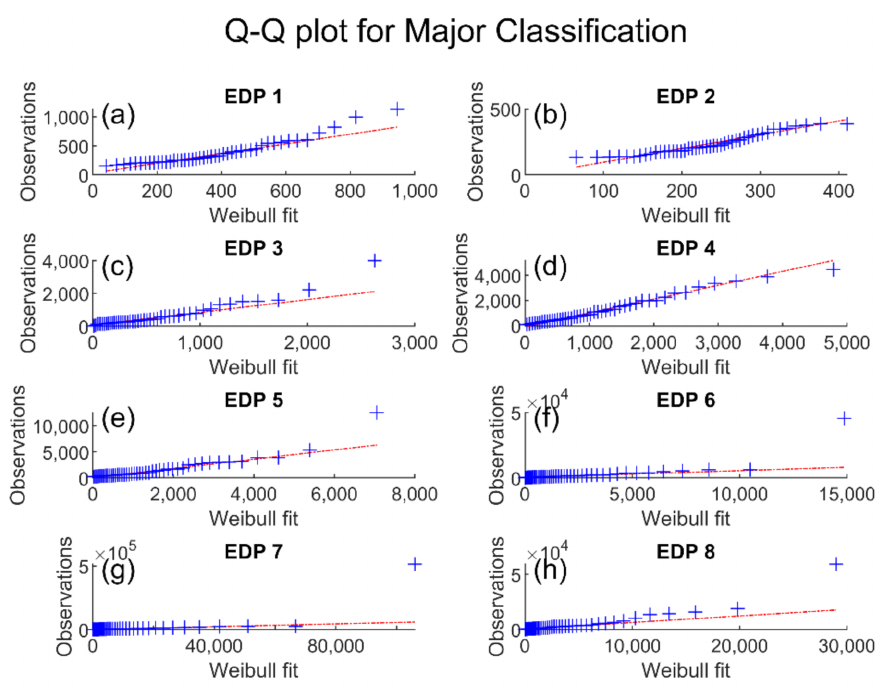
Figure 8. Weibull distribution quantile plots for all observations corresponding to Major classification. ( a ) EDP 1—Berm Width; ( b ) EDP 2—Berm and Dune width; ( c ) EDP 3—Dune Volume; ( d ) EDP 4—Foredune Volume; ( e ) EDP 5—Shear; ( f ) EDP 6—Moment; ( g ) EDP 7—Simplified Mass-moment of Inertia; ( h ) EDP 8—Mass-moment of